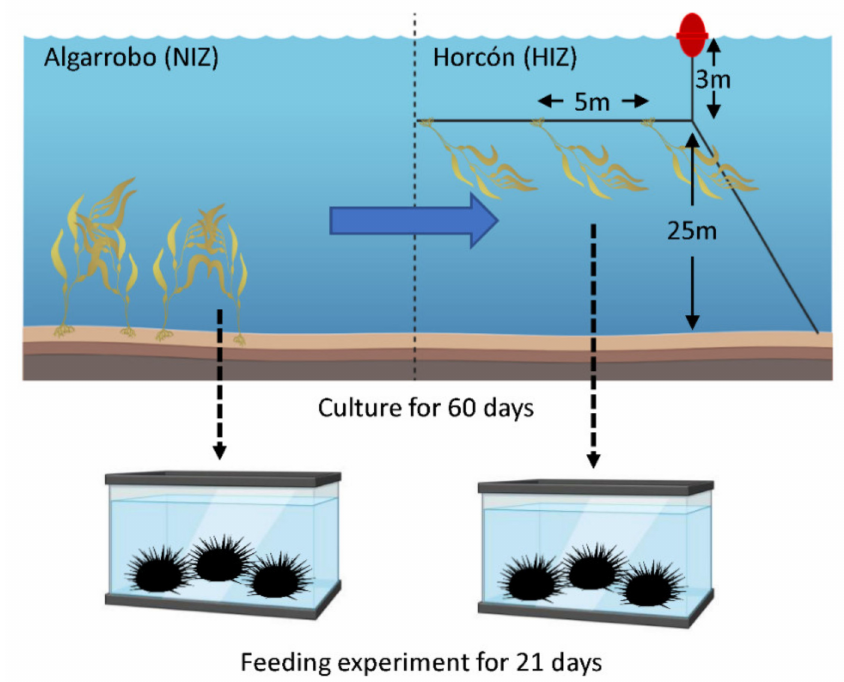
Figure 2. Simplified scheme of the culture and feeding experiments. The blue arrow indicates the origin and destination of the 15 Macrocystis pyrifera individuals, and the dashed arrows correspond to the origin of the kelp tissue for the feeding experiment according to the